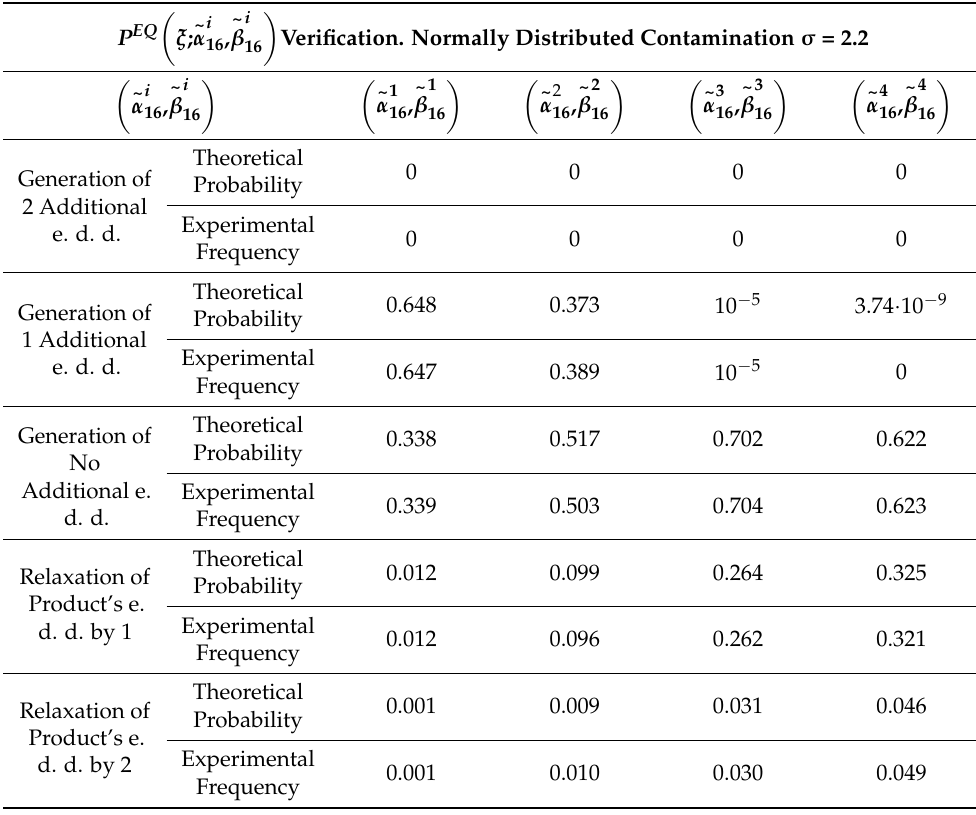
(cid:0) (cid:1) − (cid:0) (cid:1) ι ι # edd . (cid:101) γ (cid:101) α 16 16